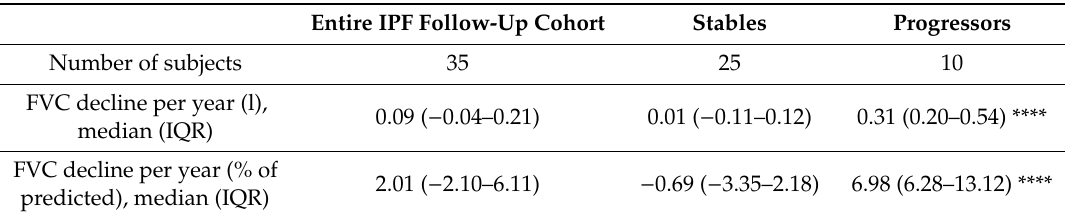
Table 3. Functional decline in the studied cohort of patients with